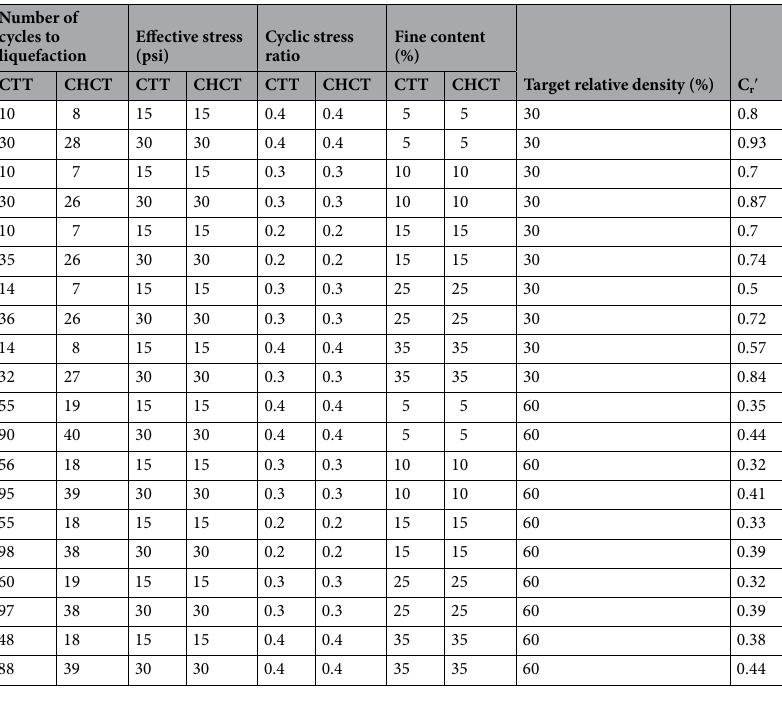
Table 5. C r ′ values on the mixture samples produced in laboratory by CTT and